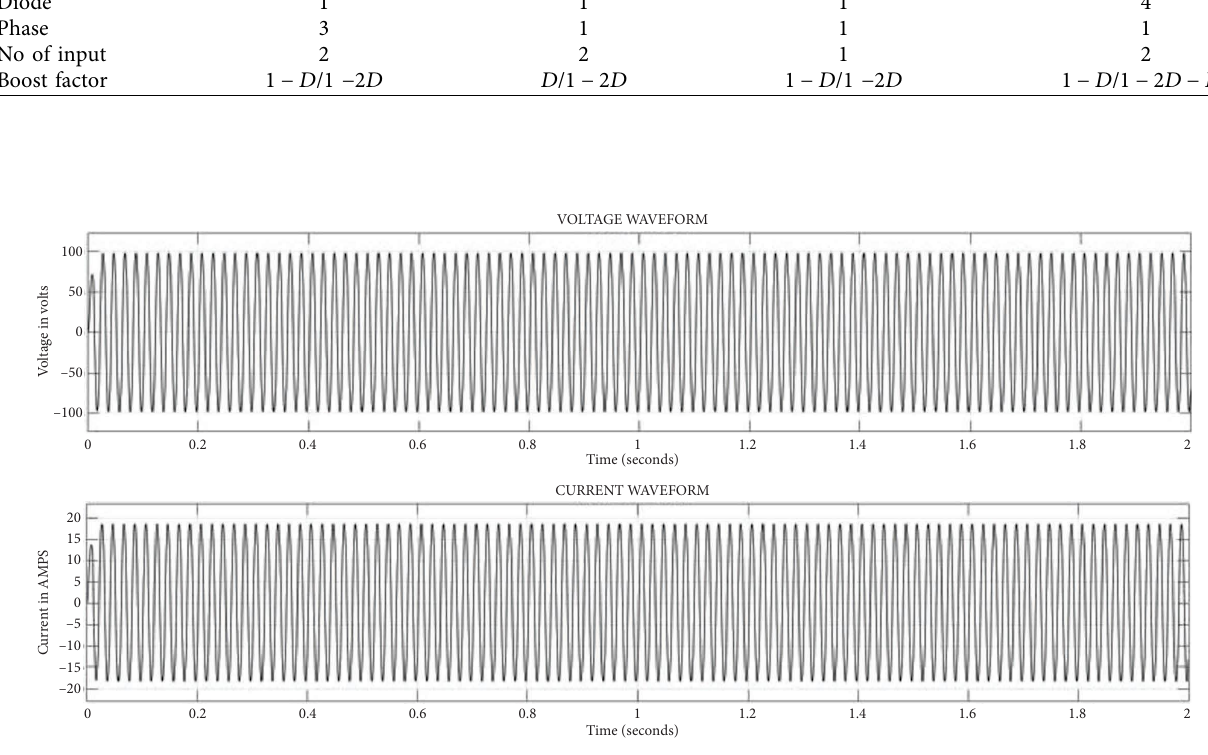
Figure 11: Output waveform during mode 1.